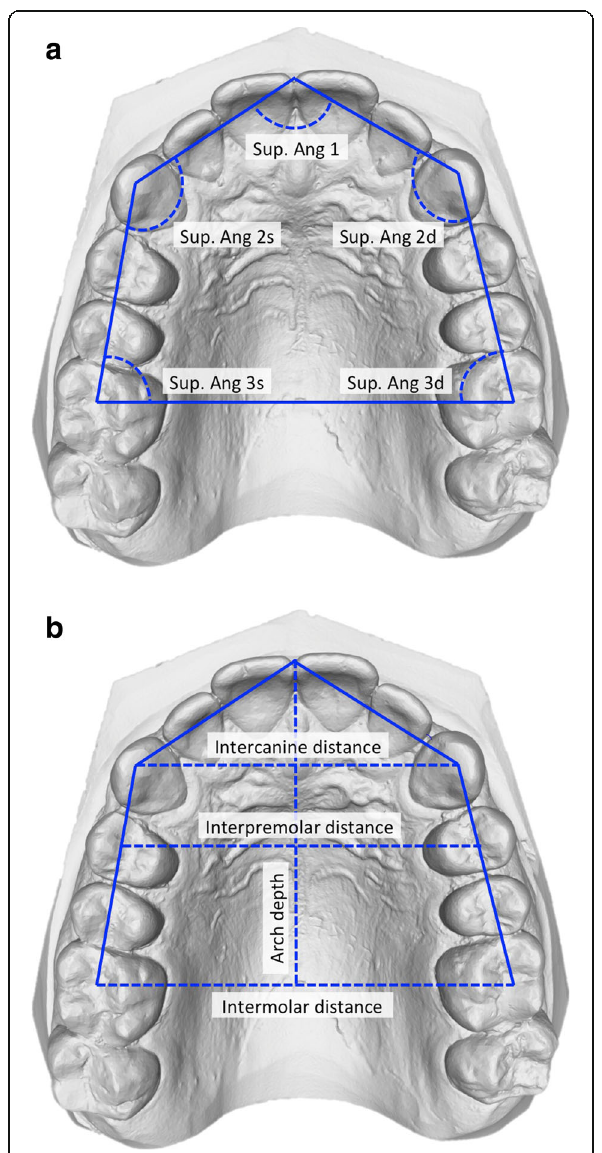
Fig. 2 a , b Method and variables for the shape analysis of the maxilla